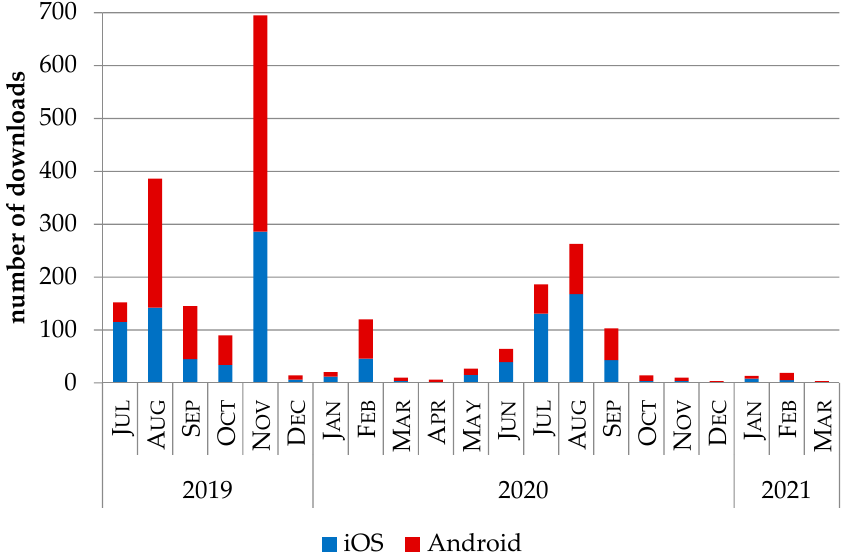
Figure 2. Number of downloads of avvistAPP per month. Of the 971 registered users, 40% (385 users) sent at least one sighting, resulting in a total of 1224 sightings. The highest number of sightings were related to observations made along the Italian Adriatic coast (with a particular focus in the Gulf of Trieste) but several sightings also arrived from Croatia and Slovenia, as well as from the Tyrrhenian coast of Italy (Figure 3).